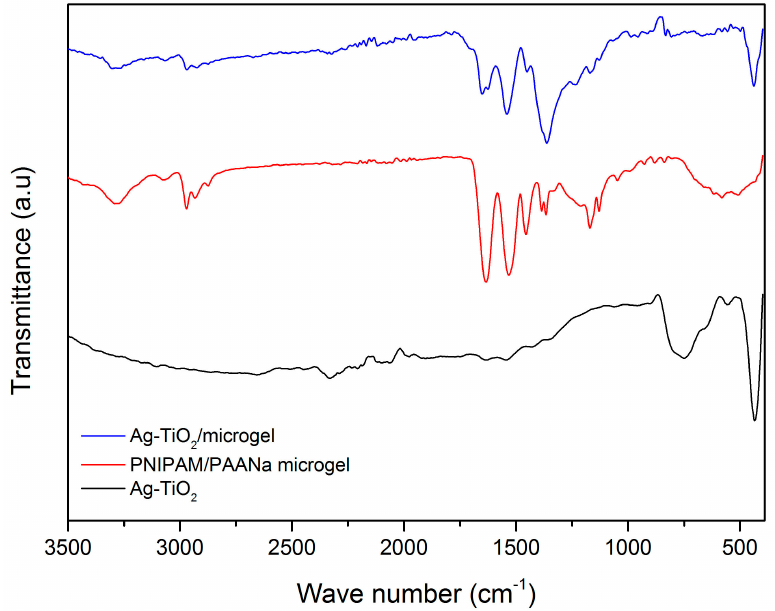
Figure 5. FT-IR spectra of Ag-TiO 2 nanoparticles (in black), PNIPAM/PAA salt (in red) and PNIPAM/PAA microgel/Ag-TiO 2 composite (in blue).